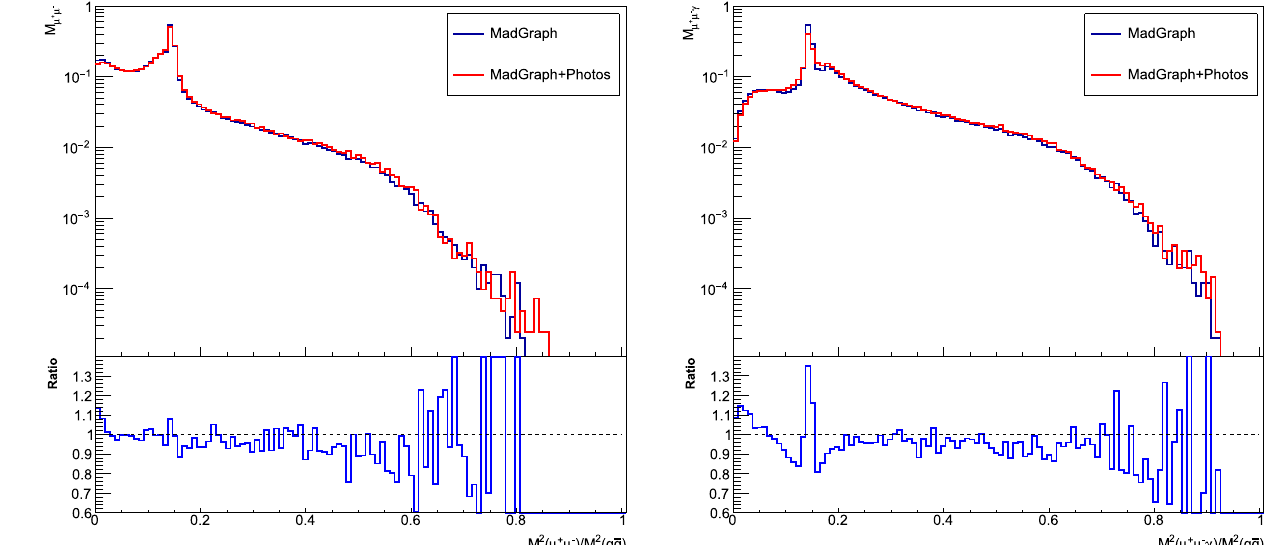
Fig. 5 The distribution of μ + μ − invariant mass for with all possible μ + μ − pairs contributing (for each event four entries/- combinations are added in the histogram). The upper panel shows the absolute distributions from the two generators, the lower panel shows the ratio of the two. The agreement is much better than what could have been deduced from Appendix B.3, where technical bias due to identical